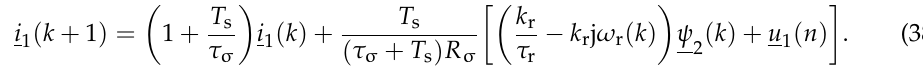
Figure 6. Stator flux linkage vector candidates (stator resistance neglected): ( a ) star-connected winding; ( b ) delta-connected